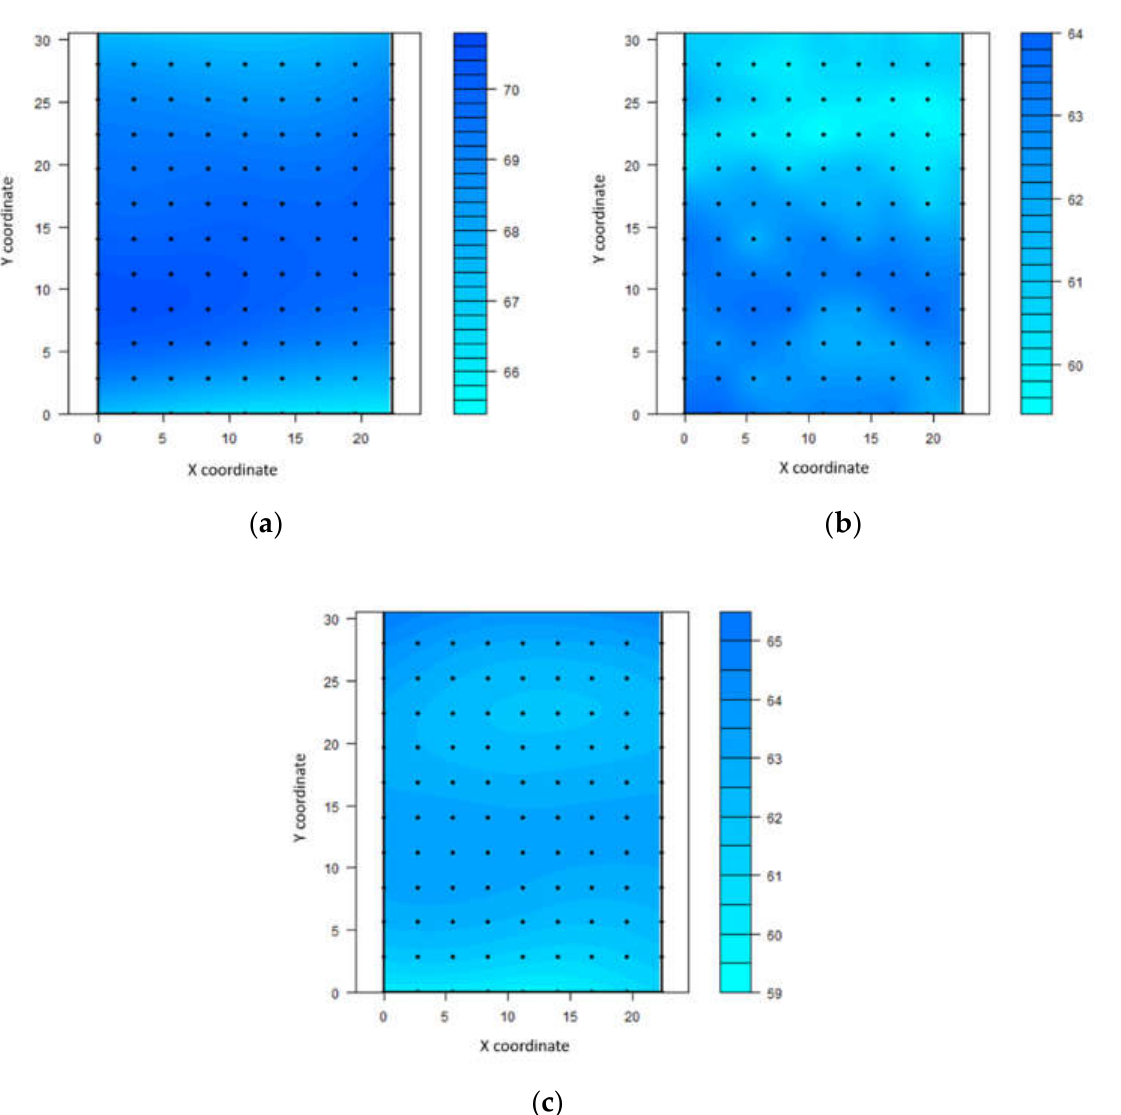
Figure 3. Spatial distribution of relative humidity (%) in compost-bedded pack barn between 09:00 and 12:00 h ( a ), between 12:00 and 15:00 h ( b ), and between 15:00 and 18:00 h ( c ).